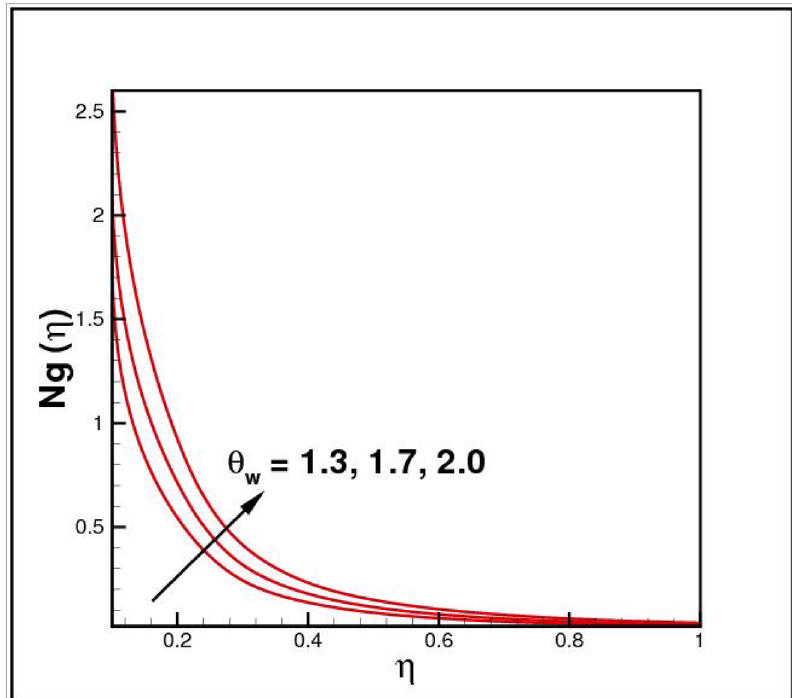
Figure 13. Impact of θ w on Ng ( η ).